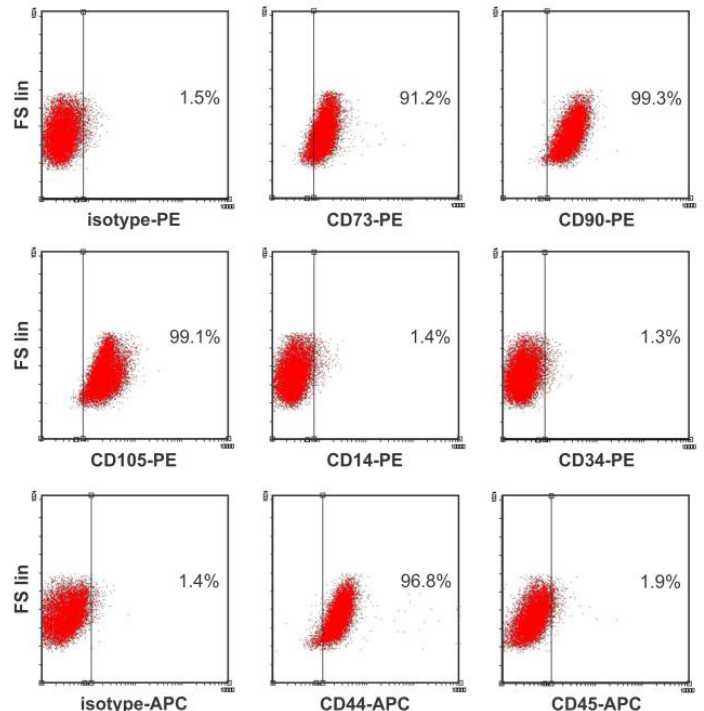
Figure 1. Phenotypic characterization of bone marrow-derived mesenchymal stromal / stem cells (BM-MSCs). Surface marker expression levels in BM-MSCs were analyzed by flow cytometry. MSCs highly express ( > 90%) the stromal determinants CD44, CD73, CD90, and CD105, and are negative ( < 2%) for the expression of hematopoietic markers (CD14, CD34, CD45). Representative dot-plots of three independent assays.